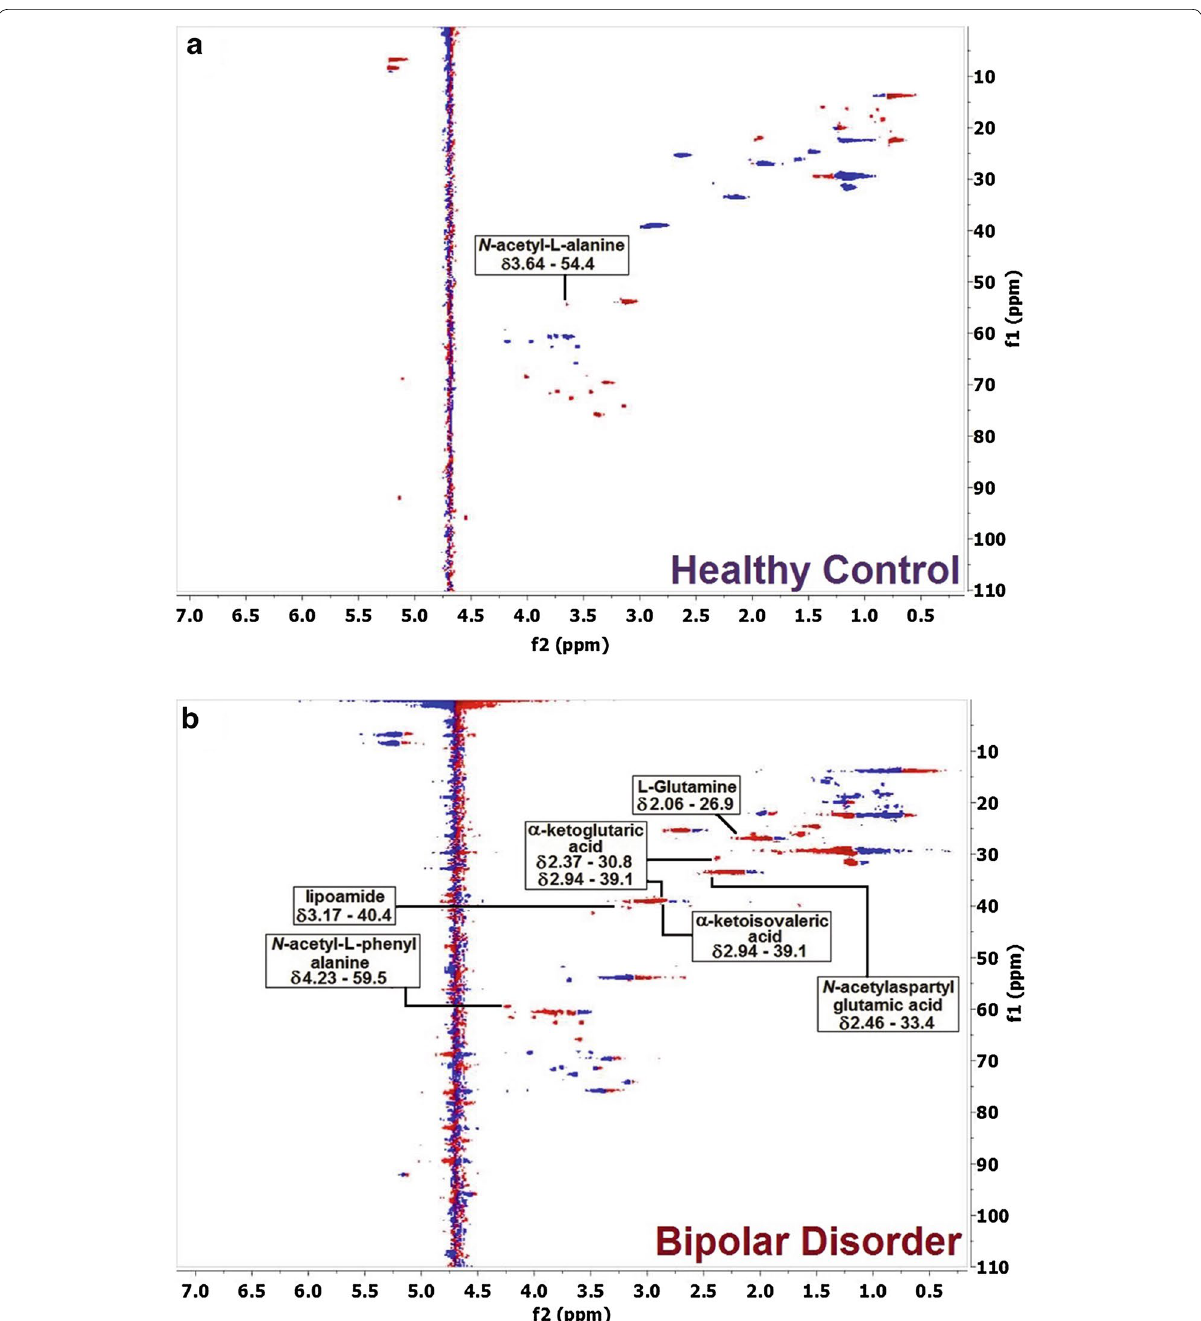
Fig. 3 Two‑dimensional NMR Spectra: Contour maps of HSQC (pulse sequence: hsqcedetgpsp.3) blood serum sample from ( a ) HC (ns SD 16), and b BD group (ns =